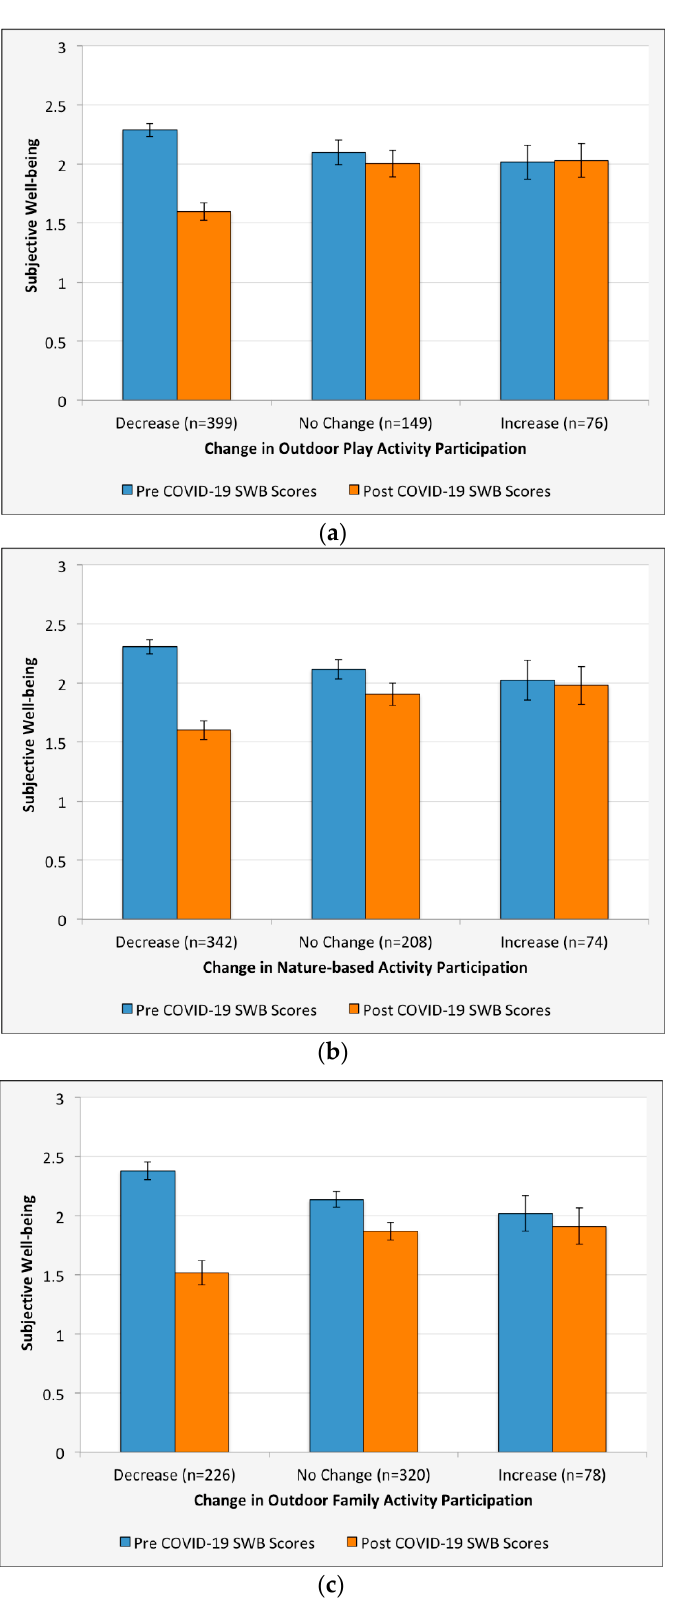
Figure 2. Changes in subjective well-being scores by changes in rates of outdoor play activity ( a ), nature-based activity ( b ), and outdoor family activity ( c ) participation pre and post COVID-19 pandemic for adolescents in the United States ( n = 624). Mean activity scores ranged from 0 (at no time) to 3 (all of the time).